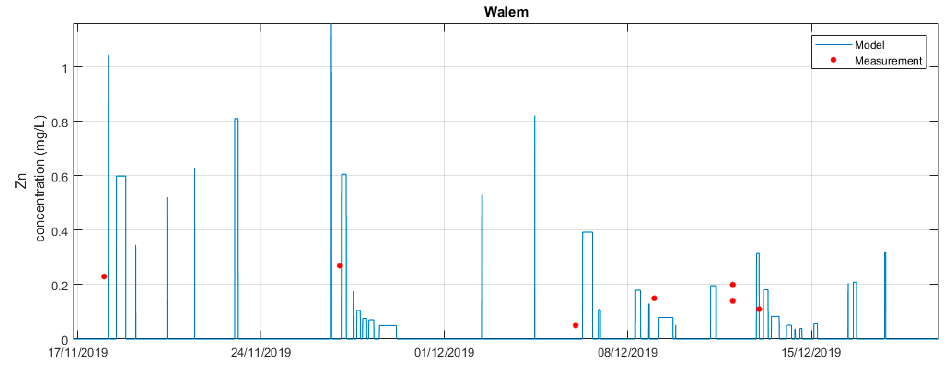
Figure 4. Detail of the modelled Zn concentrations in Walem.